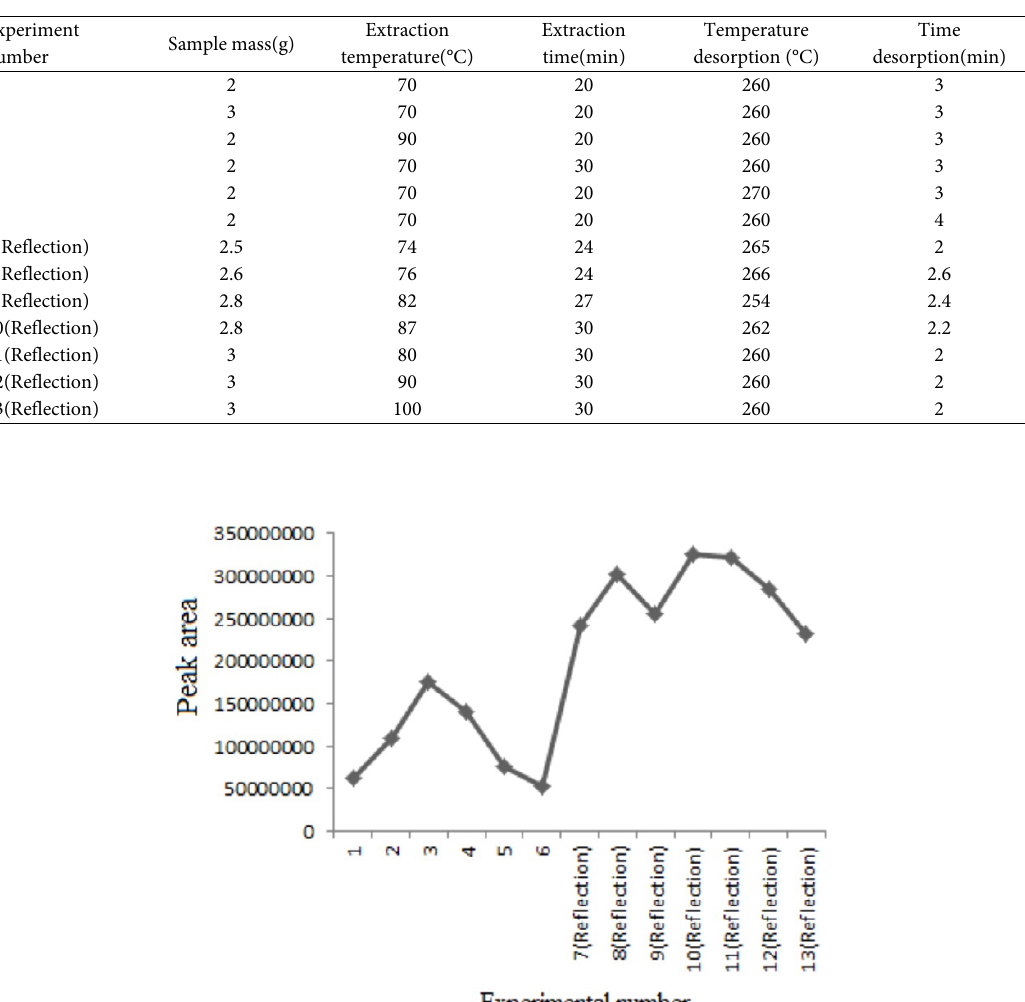
Table 1 . Experimental conditions used and results obtained for the HS-SPME experiments performed in the simplex optimization procedure